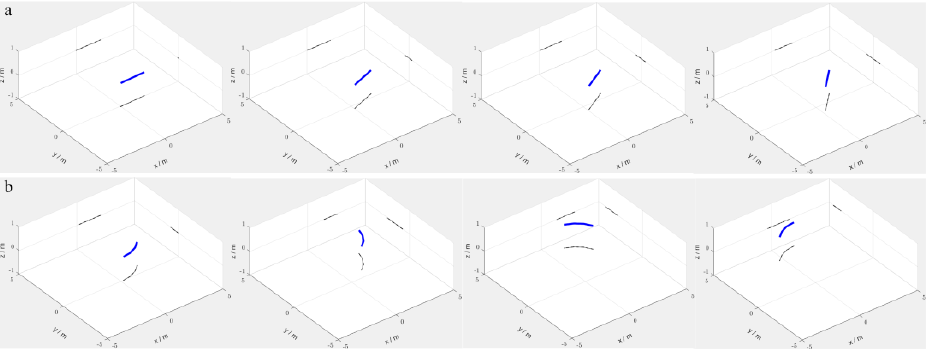
Figure A1. Physical diagram of micro water pump integrated system for underwater snake robot.